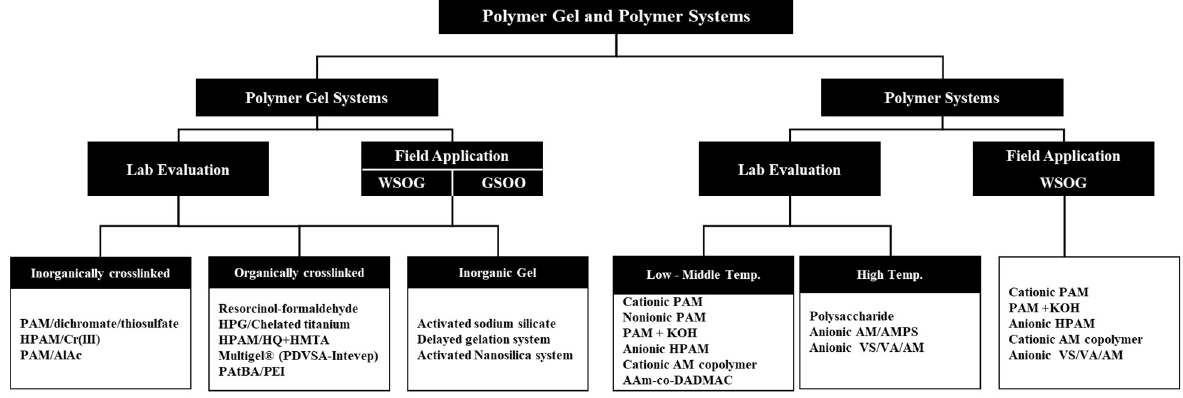
Figure 3. Polymer gel and polymer systems for WSOGs and GSOOs.